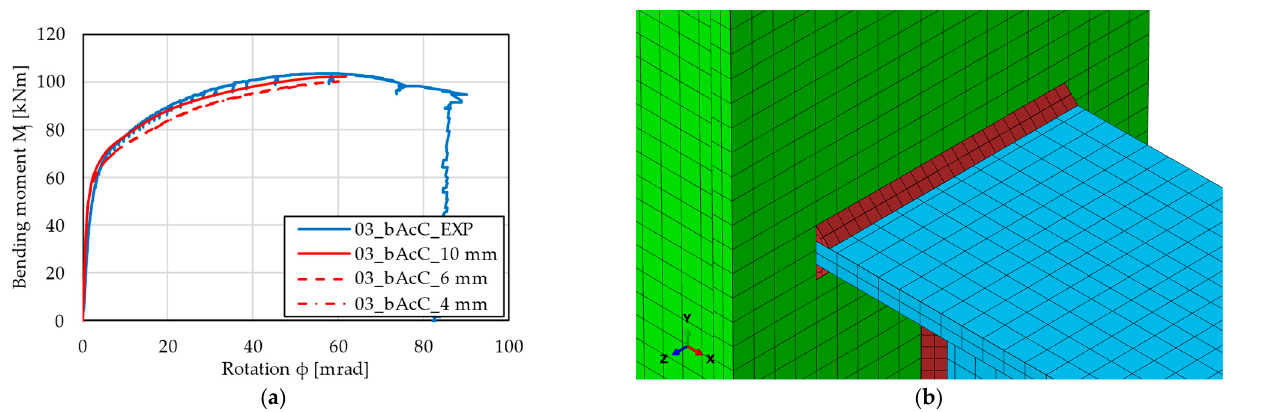
Figure 4. Discretization of numerical model: ( a ) sensitivity to different finite element sizes; ( b ) opti- Figure 4. Discretisation of numerical model: ( a ) sensitivity to different finite element sizes; mal mesh. ( b ) optimal